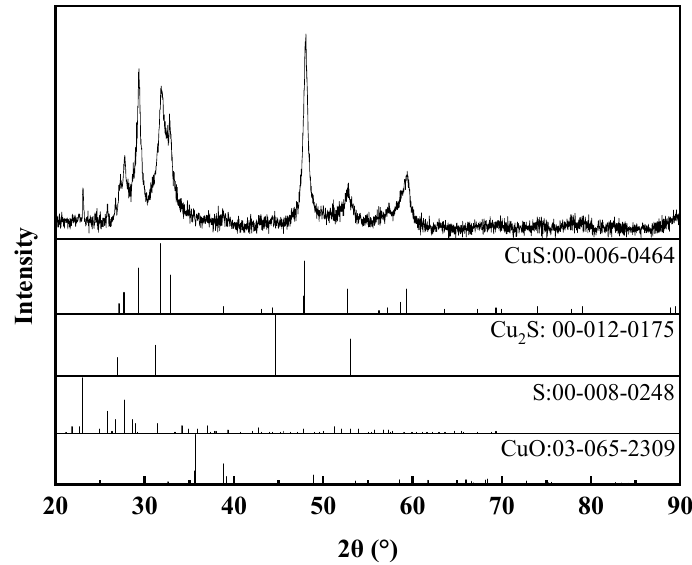
Figure 6. XRD patterns of photoproducts ([Cu] = 50 mg/L, [S 2 O 32 − ] = 0.1 mol/L, 298 K, uncontrolled pH).